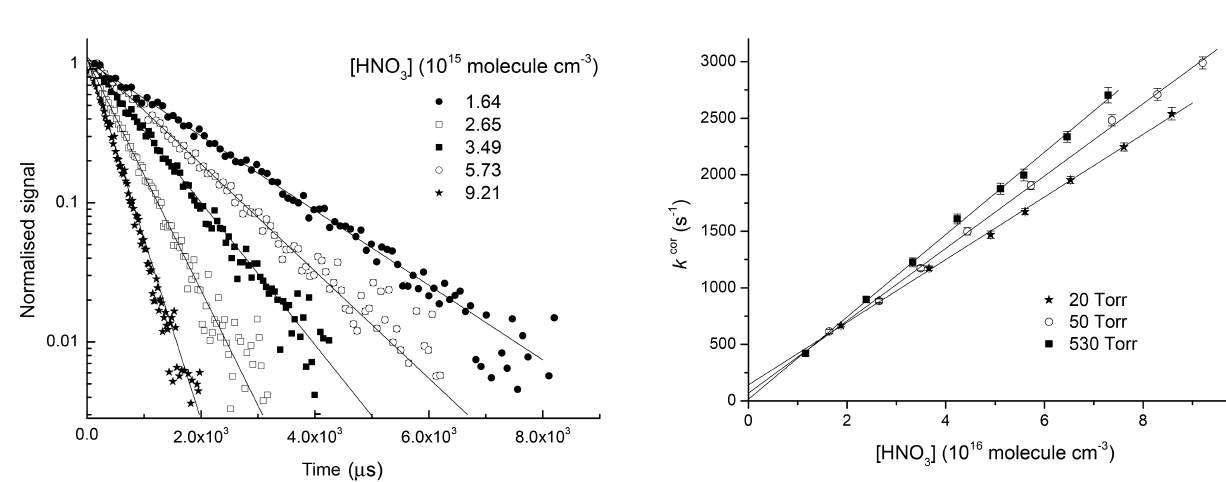
Figure 5. Temporal decay of the OH-LIF signal at 242K and 50TorrN 2 .